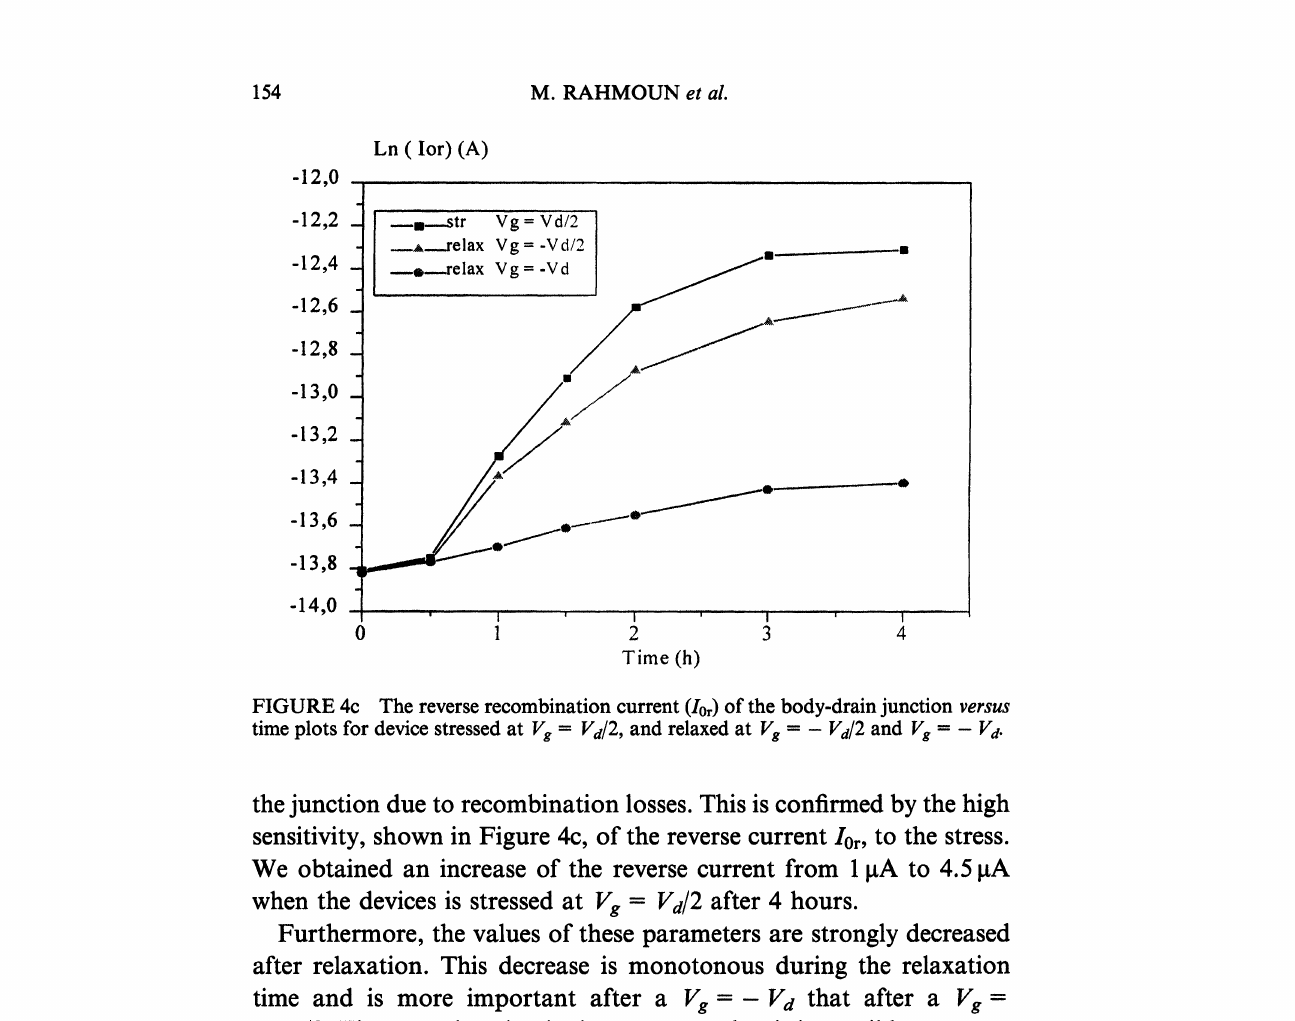
FIGURE 4c The reverse recombination current (10r) of the body-drain junction versus time plots for device stressed at Vg Va/2, and relaxed at V Va/2 and V